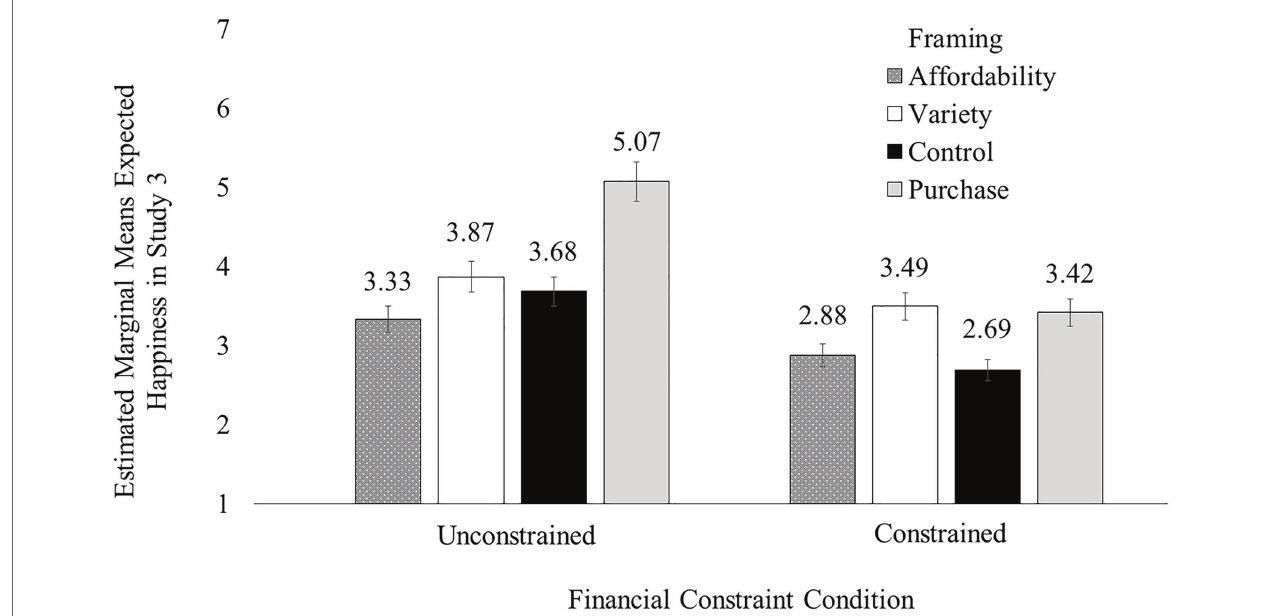
FIGURE 3 | The financial constraints × framing interaction effect on happiness in Study 3.